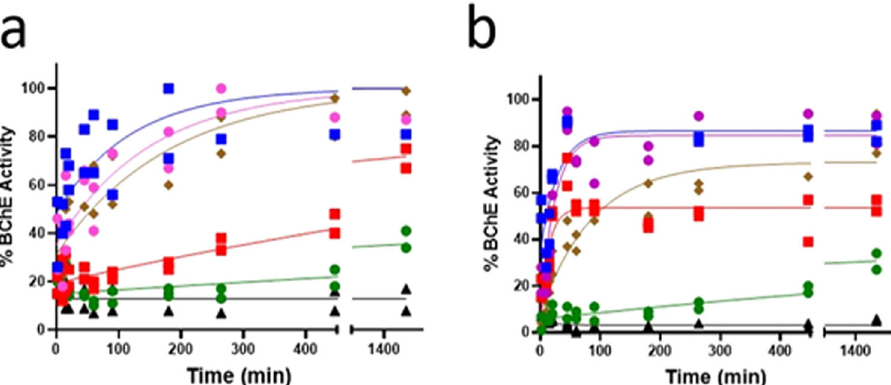
Fig. 2 Reactivation of Sarin- and VX-inhibited BChE. Time-course of reactivation of a Sarin-inhibited BChE and b VX-inhibited BChE by PCM-0211088 (purple circles), PCM-0211955 (blue squares) PCM-0212399 (red squares), PCM-0211338 (green circles), and HI-6 (brown diamonds). [Oxime], 0.5 mM. VX-BChE reactivation was performed following inhibition by [VX] = 10 − 6 M, [BChE] - 2 × 10 − 6 M. Sarin-BChE reactivation was performed following inhibition by [Sarin] 3 × 10 − 6 M, [BChE] 2.5 × 10 − 6 M, [oxime] 0.5 mM, 10 mM phosphate pH = 8.0 (black triangles), 25 °C. Data are provided in Supplementary Data fi le